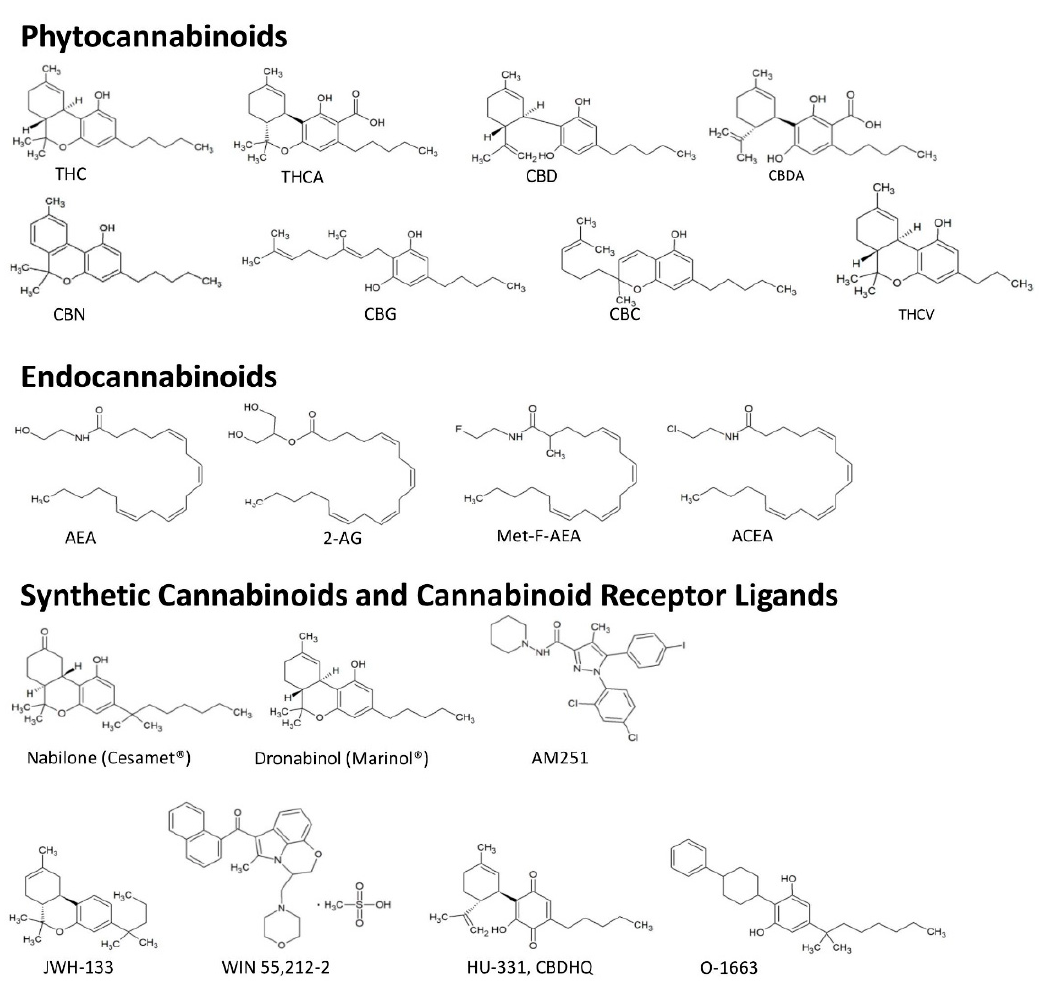
Figure 1. Chemical structures of cannabinoids. Phytocannabinoids —THC: Delta-9-